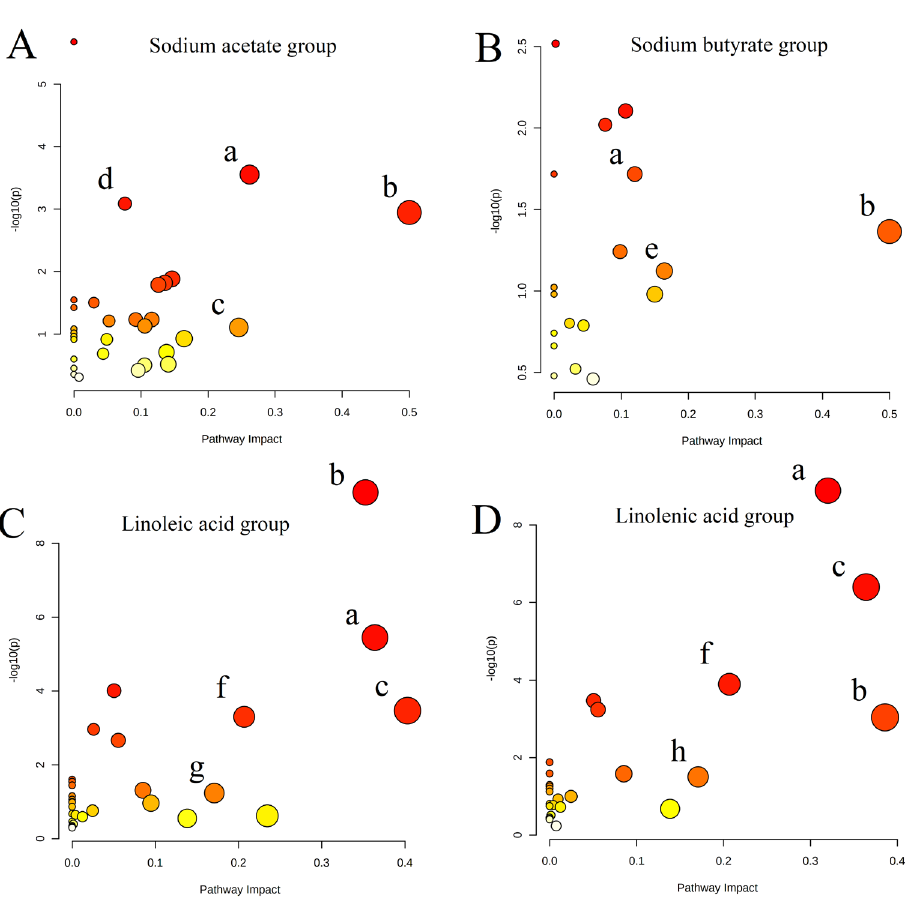
Figure 4. Global metabolic pathways are affected by four fatty acid groups: ( A ) sodium acetate, ( B ) sodium butyrate, ( C ) linoleic acid, and ( D ) linolenic acid. The following abbreviations were utilized: a—glycerophospholipid metabolism; b—citrate cycle (TCA cycle); c—gluconeogenesis; d—Aminoacyl-tRNA biosynthesis; e—phenylalanine metabolism; f—arginine biosynthesis; g—pyrimidine metabolism; h—pyruvate metabolism.